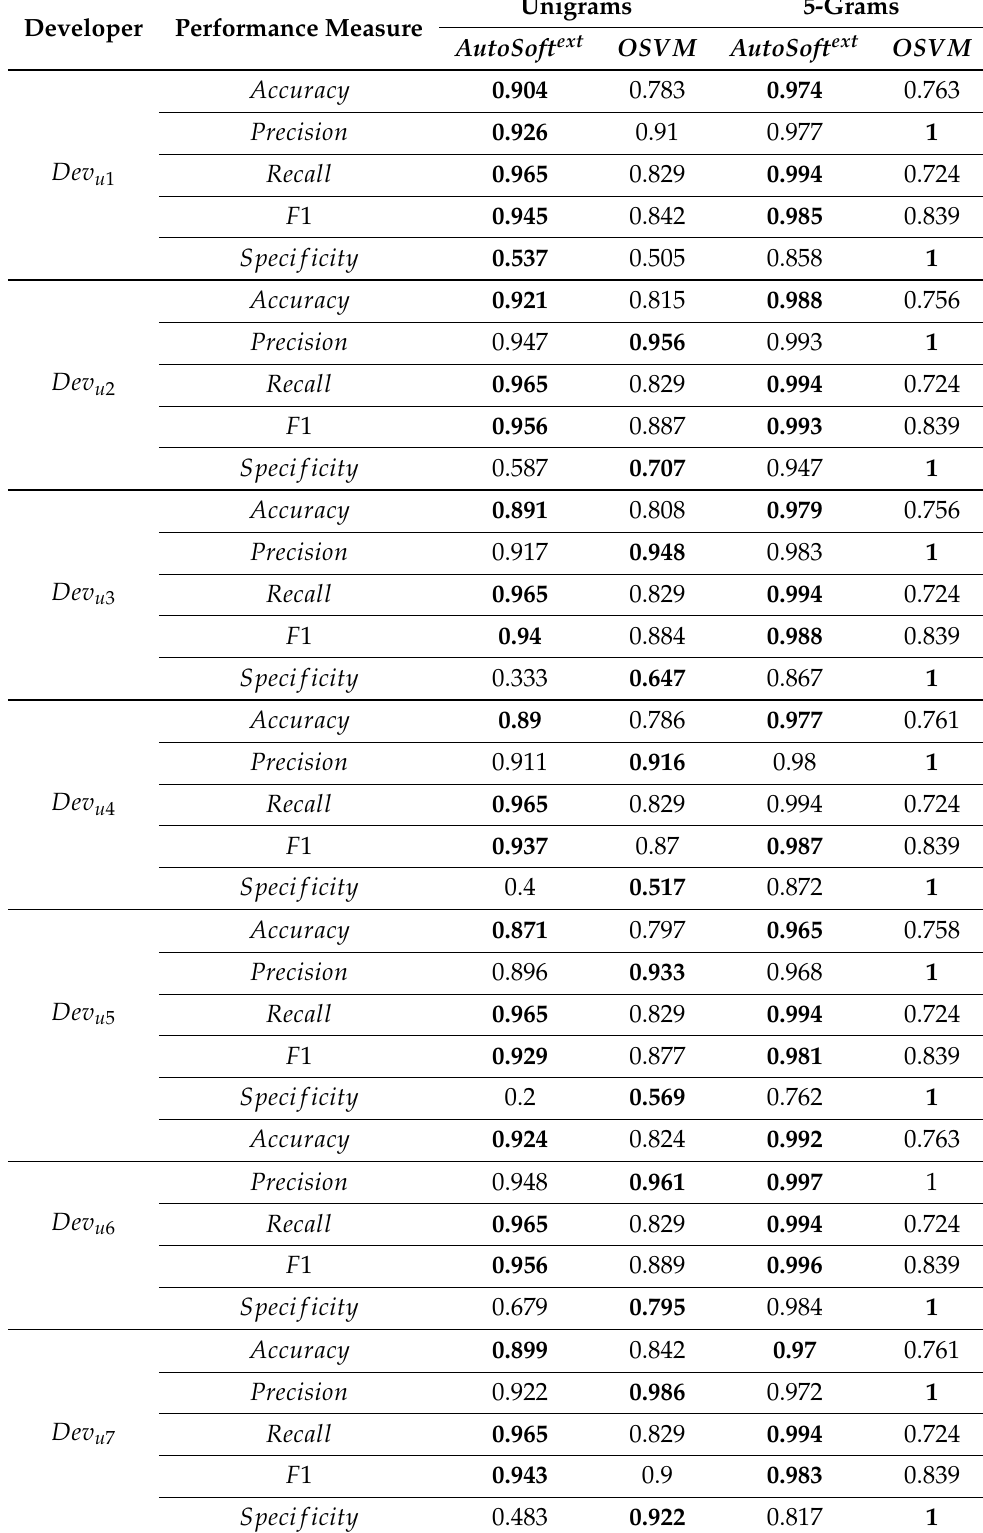
Table 5. Comparison between AutoSoft ext and OSVM with respect to N -gram size for seven “un- known” authors and an O riginal set with n =